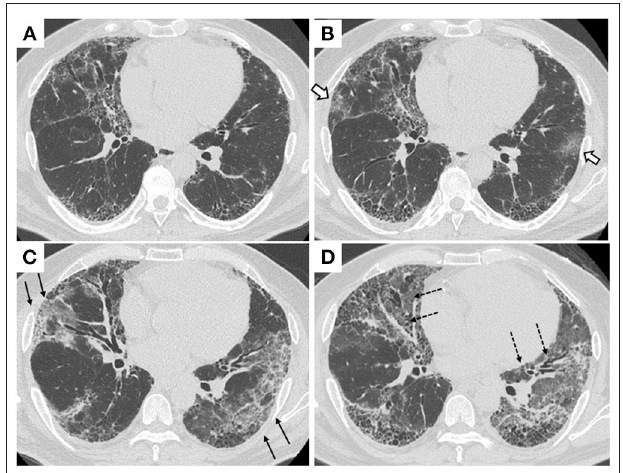
FIGURE 1 | Chest CT scans. (A) On his last regular visit prior to the first admission. (B) On his first admission due to COVID-19. Open arrows indicate newly developed ground-glass opacities in the outer zones of both lungs. (C) On day 15 of his first admission, just before discharge. Arrows indicate ground-glass opacities were increased but limited to the outer zones of both lungs. (D) On his re-admission due to AE-IPF. Broken arrows indicate extensive ground-glass opacities spread to the inner zones of both lungs.